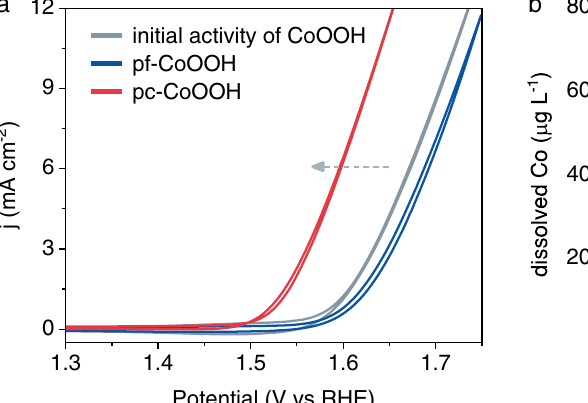
Fig. 1 | Ligand-promoted oxygen evolution activity. a The j-V curves of pf- CoOOH and pc-CoOOH. “ pc ” and “ pf ” represent that the pristine CoOOH pre- catalysts were treated at 1.7 V RHE for 10h in phen-containing and phen-free 1.0M